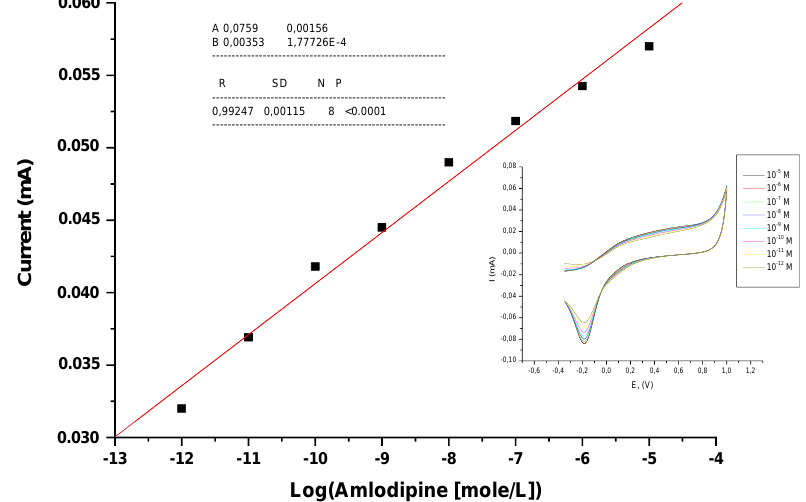
Figure 7. The relationship between peak current and logarithm of amlodipine concentration.